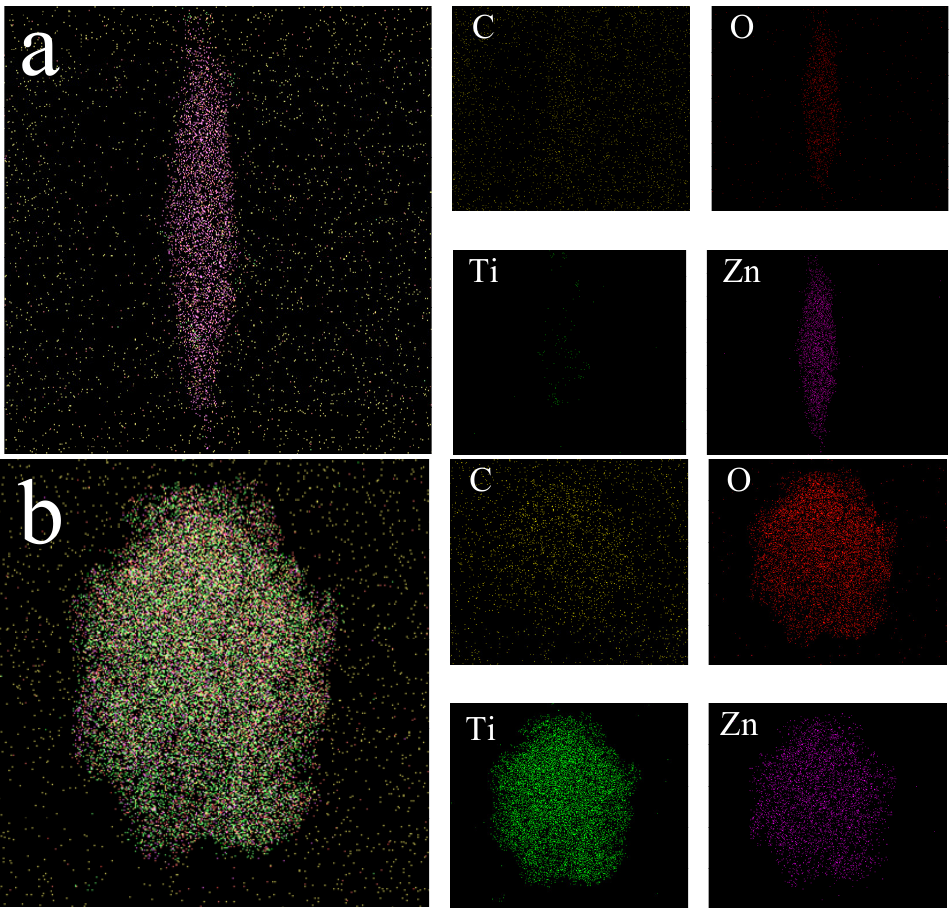
Figure 4. ( a ) ZnO-TiO 2 -rGO elemental mapping of rod-shaped ZnO. ( b ) ZnO-TiO 2 -rGO elemental mapping of spherical TiO 2 .